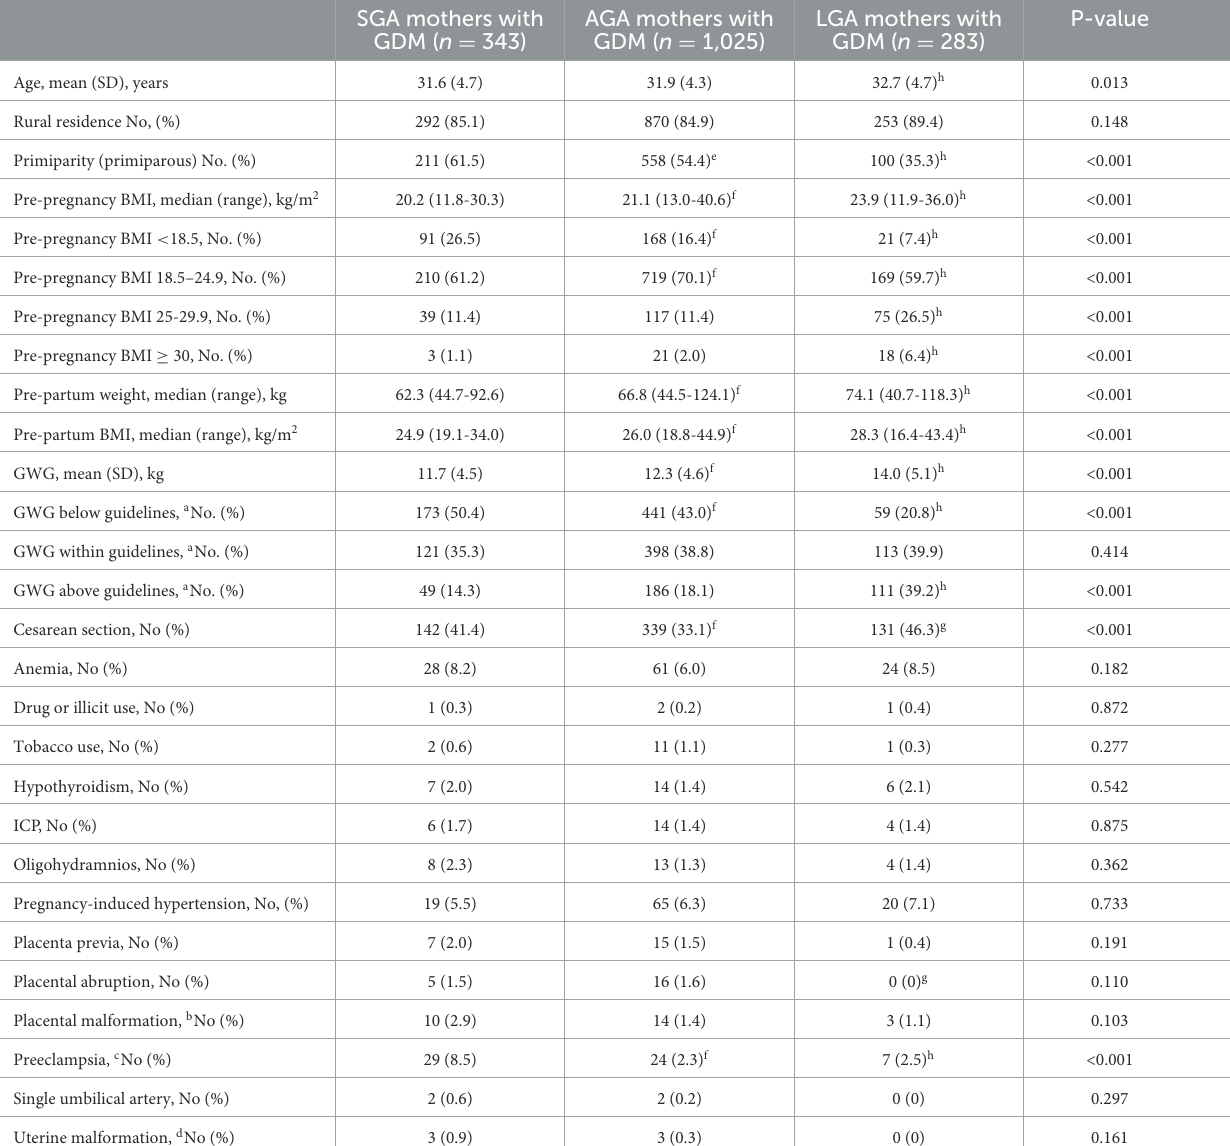
TABLE 1 Clinical characteristics of the pregnant women ( N = 1,651).